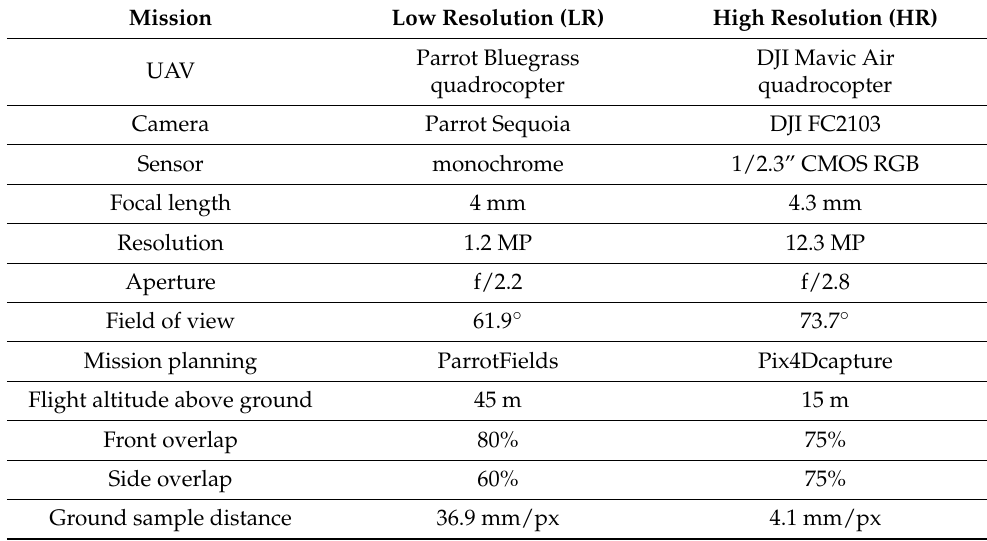
Table 2. List of utilized UAVs, sensor specifications, and mission